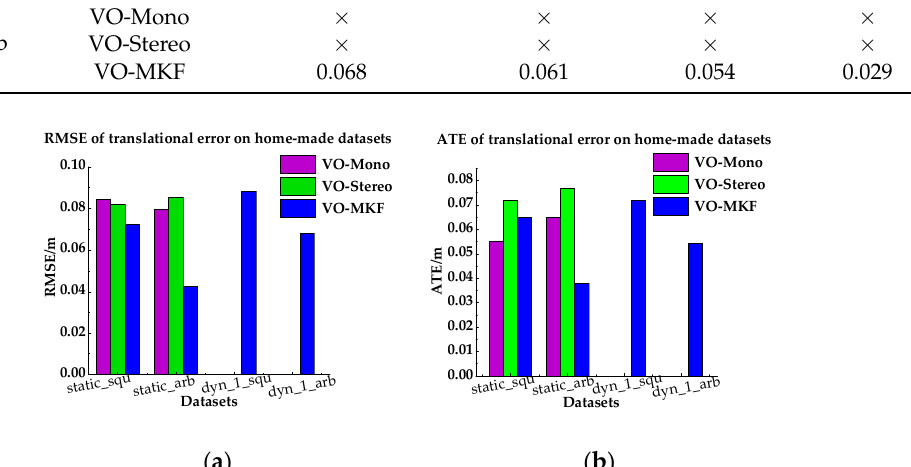
Figure 13. RMSEs and Median ATEs for VO-Mono, VO-Stereo and VO-MKF. ( a ) RMSEs of translational error; ( b ) median ATEs of